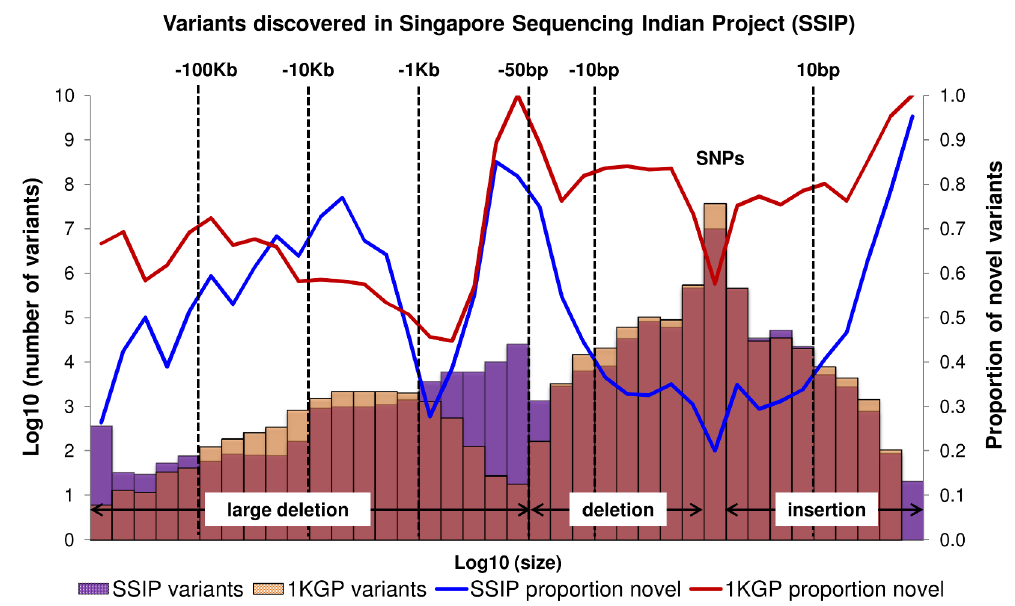
Figure 1. Size distribution and novelty of variants in SSIP. Autosomal variants identified in the 36 SSIP samples, which included single nucleotide polymorphisms (SNPs), small insertion/deletions (indels) between 2 bp to 50 bp, and large deletions between 51 bp to 1 Mb. The SSIP SNPs and indels are defined as novel if they are not present in SSMP and dbSNP137, whereas dbSNP132 was used for defining the novelty of the 1 KGP SNPs and indels. The novelty of large deletions in SSIP and 1 KGP is defined with respect to SSMP and DGV release